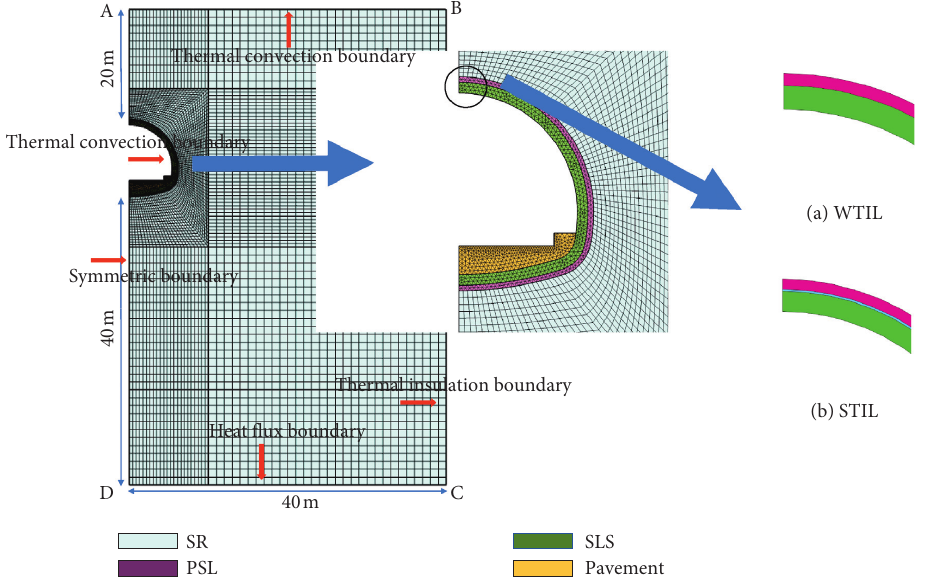
Figure 3: Numerical model of the Altun mountain